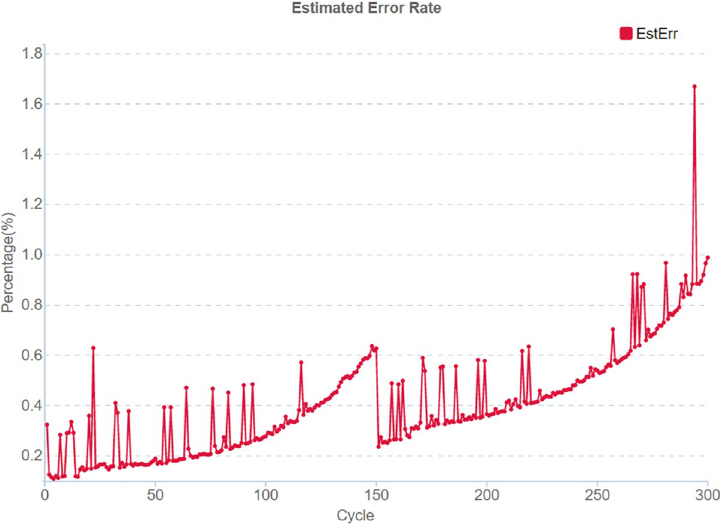
Fig 4. Error rate for a single-lane SNR for a PE150 run on MGISEQ-2000. The error rate increases with the increase in the cycle